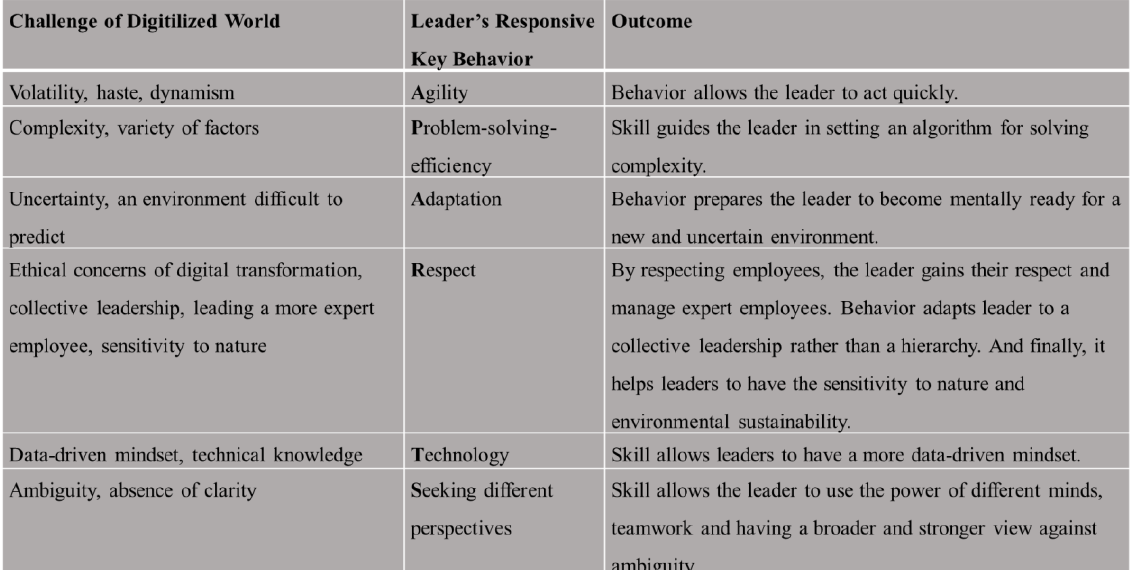
Table 1 - Technoversal Leader Overcoming Challenges by Employing Key